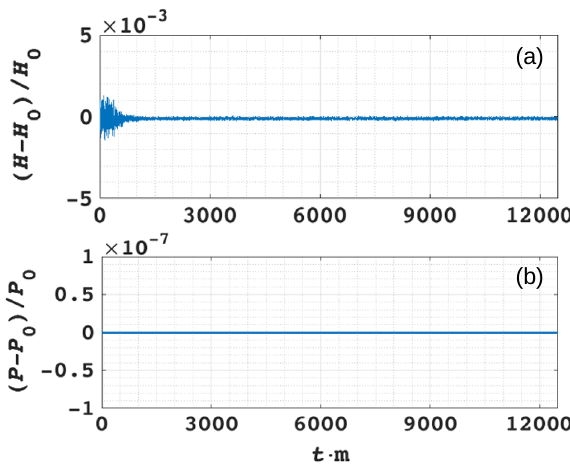
Figure 4 . Numerical errors of the conserved quantities. (a) Relative error of the total Hamiltonian. (b) Relative error of the total probability. Where the subscripts 0 of the total Hamiltonian H and probability P indicate the initial values. ( m = 0 . 25 , ∆ t = 0 . 05 , ∆ x i = 1 , N t = 1 × 10 6 , N x 0-spin KGM theory. Figure 3 (d) shows a weak self gauge field dressed fermion